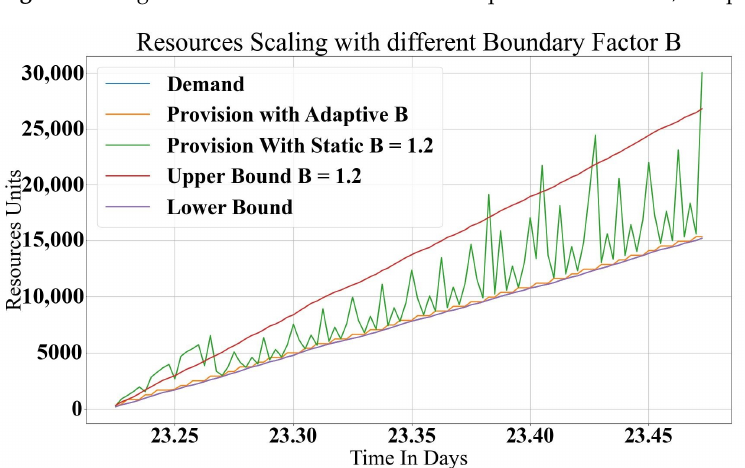
Figure 4. Google data center with Constant and Adaptive B Ratios and Gradually Increasing Re-